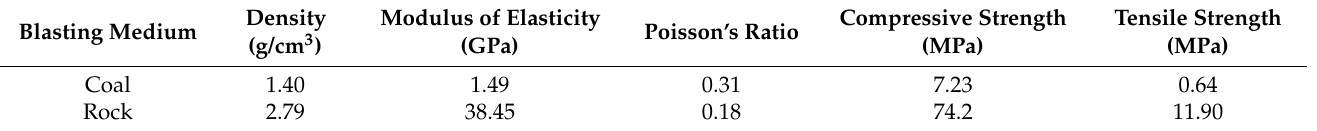
Table 2. Numerical simulation parameters of coal and rock.